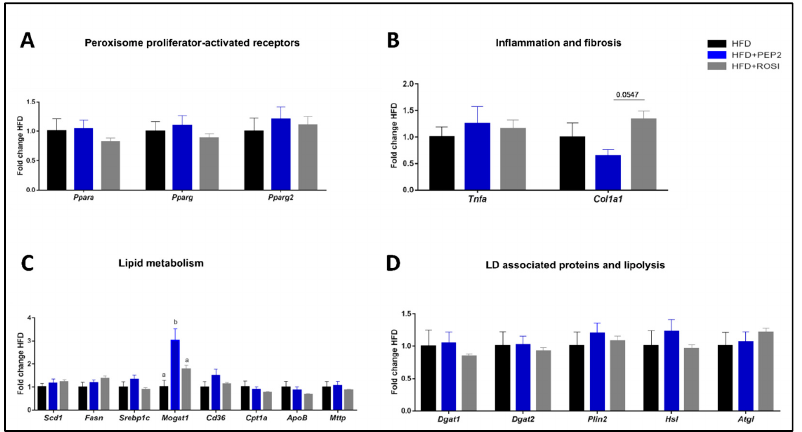
Figure 7. Liver gene expression in tissues harvested from mice treated with Peptide 2 (Protocol 2). ( A ) Peroxisome proliferator-activated receptors; ( B ) inflammation and fibrosis related genes; ( C ) lipid metabolism related genes and ( D ) LD associated proteins and lipolysis related genes. Data expressed as mean ± SEM of fold change of HFD control (n = 7–8) and analyzed by one-way ANOVA or Kruskal–Wallis test. Data normalized to β -actin gene expression. Bars with different letters indicates p < 0.05. LD, lipid